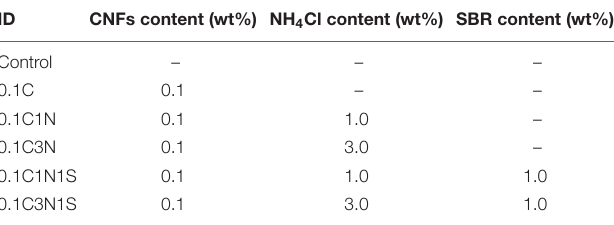
TABLE 3 | Experimental group setting (0.1 wt% CNFs for